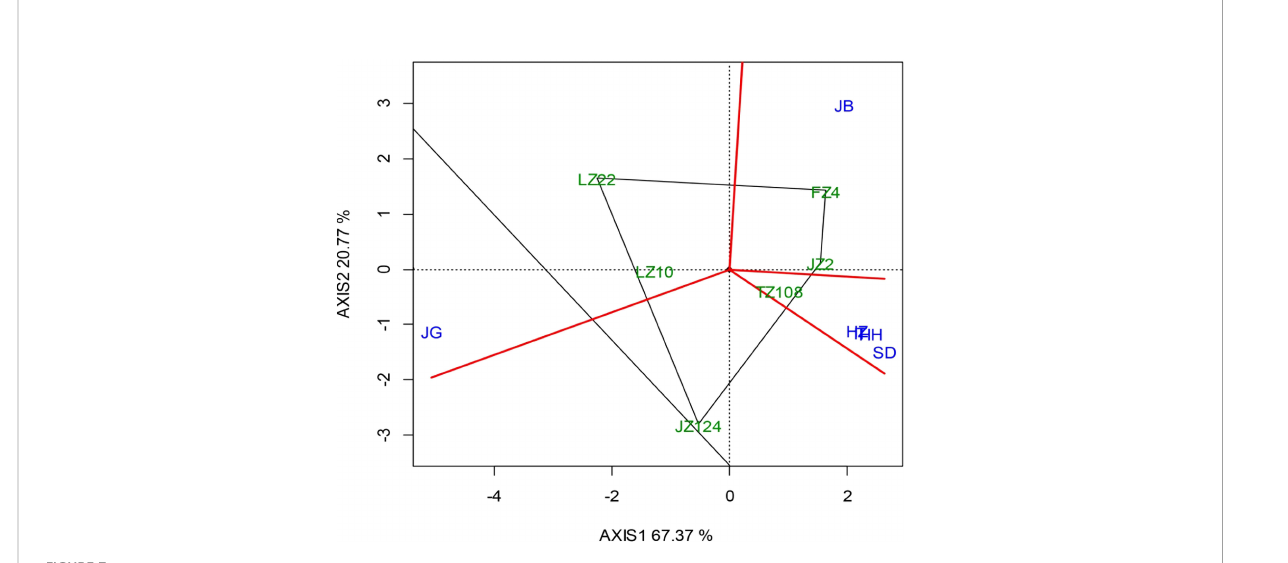
FIGURE 7 “ Which Won Where/What ” biplot under different sowing